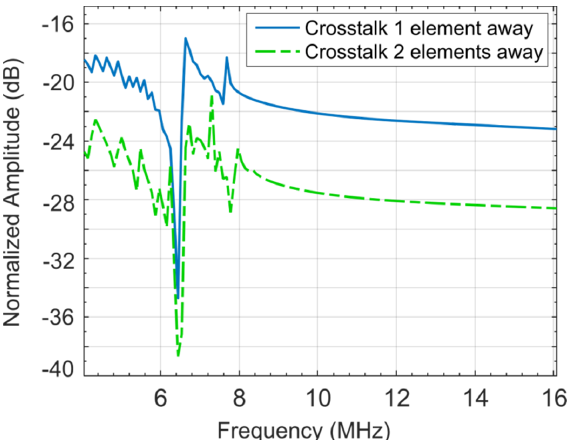
Figure 6. Crosstalk level at the nearest and the next neighbor without silica aerogel coating [21].